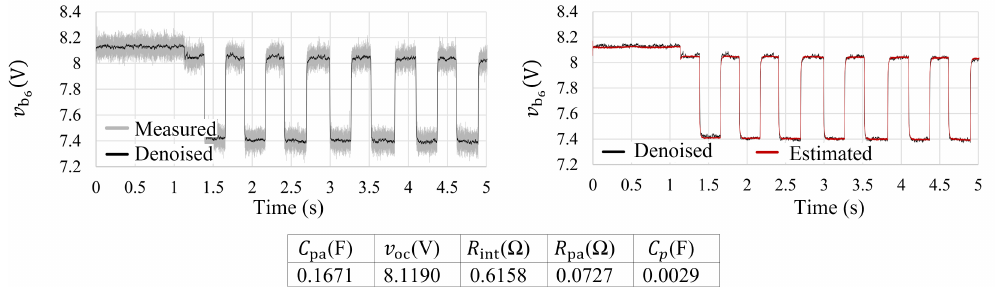
Figure 12. Scenario two: measured, denoised, and estimated output voltage of the sixth module ( v b